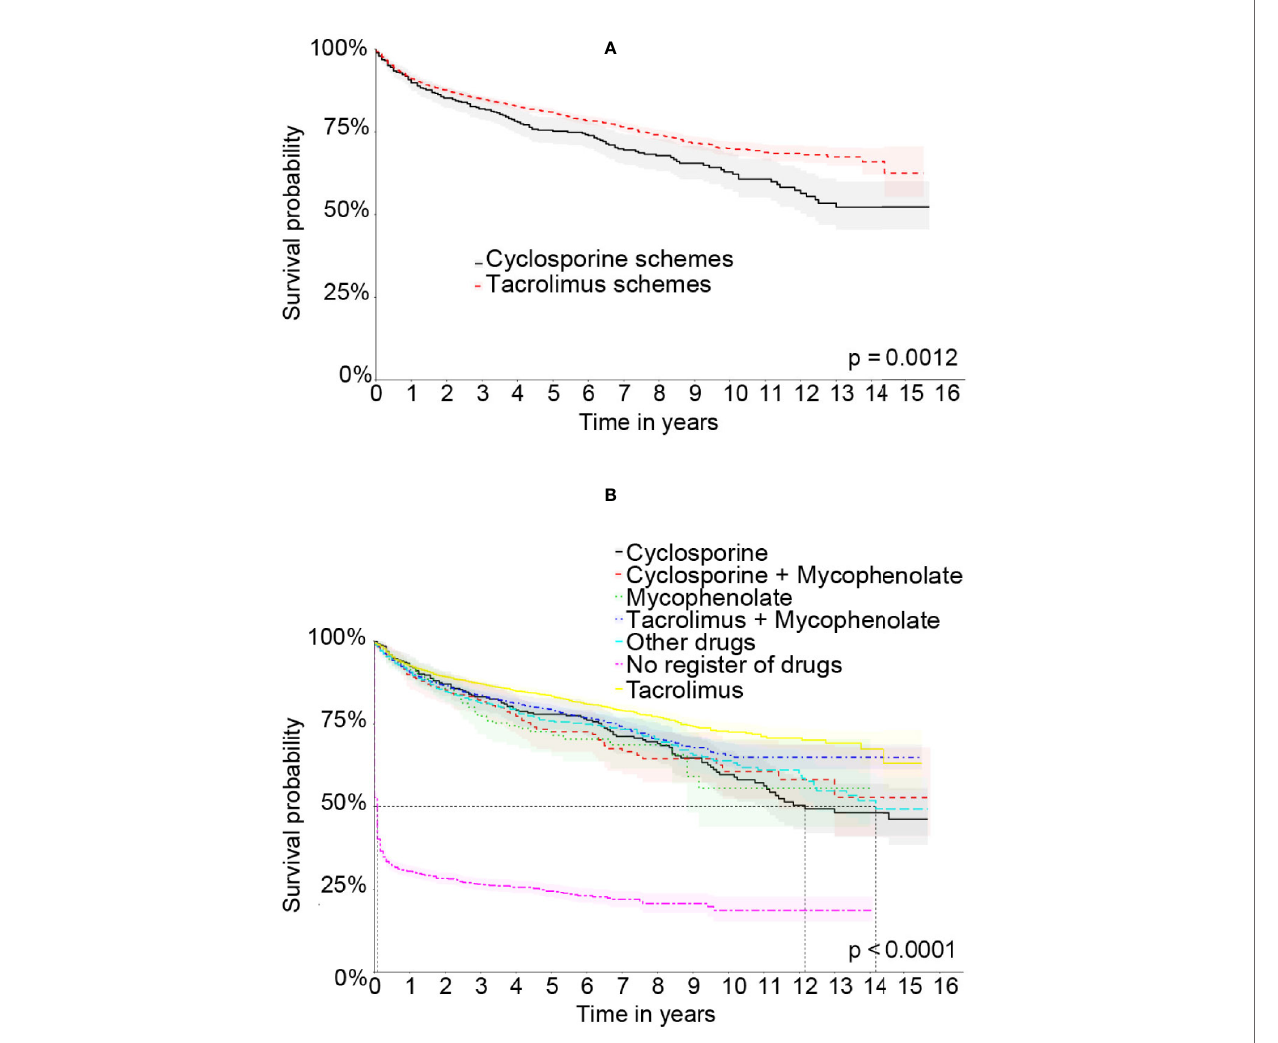
FIGURE 6 | Kaplan-Meier ’ s liver graft survival curve in the Full cohort comparing therapeutic schemes: (A) Treatment based on tacrolimus or cyclosporine. (B) The speci fi c therapeutic